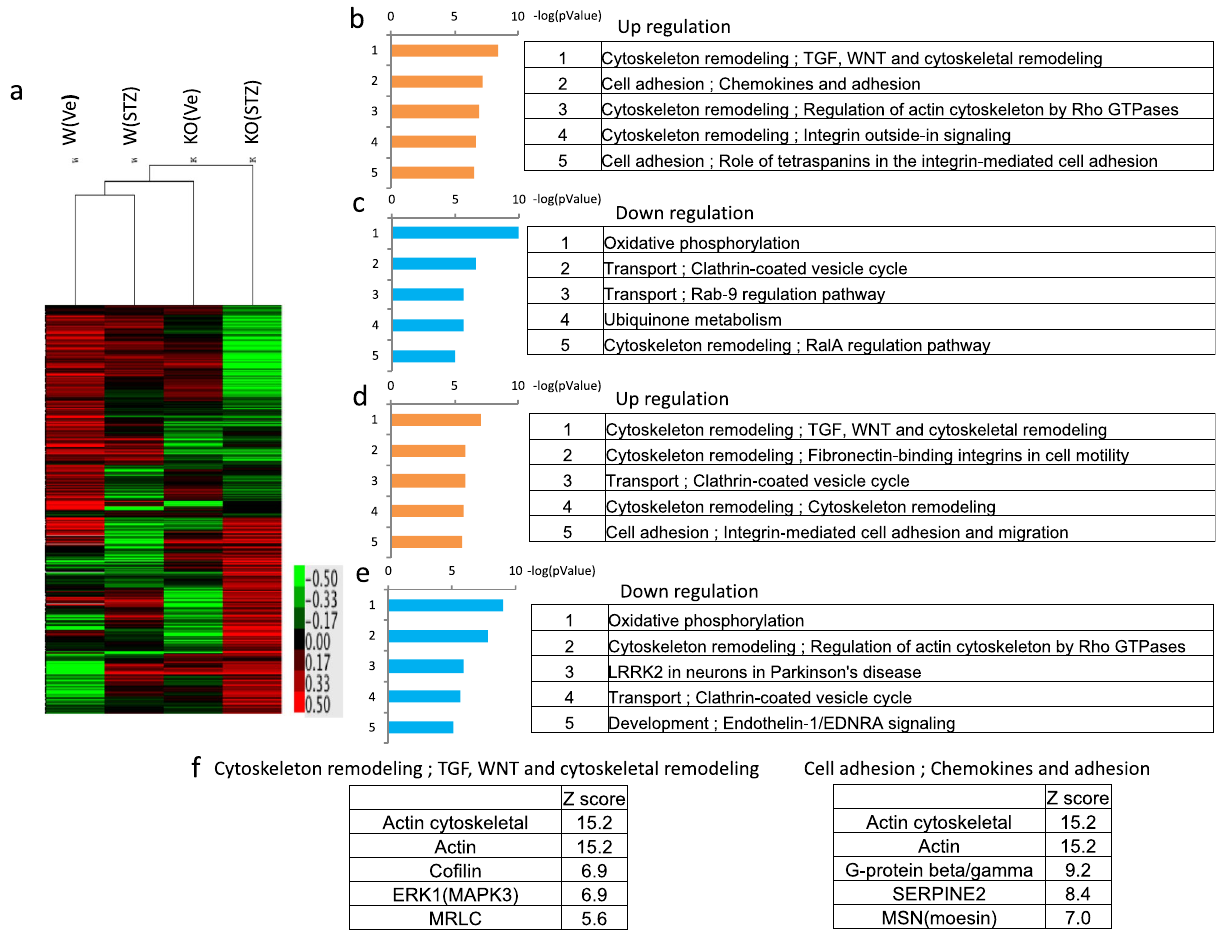
Figure 3. Comprehensive gene analysis in the kidney, and cluster and pathway analysis. As a result of the cluster analysis, gene expression of the 4 groups (WT-Ve, KO-Ve, WT-STZ, KO-STZ) was seen to be significantly different ( a ). Upregulated ( b ) and downregulated ( c ) pathways were listed to compare the WT-STZ and KO-STZ groups. Upregulated ( d ) and downregulated ( e ) pathways were listed to compare the WT-Ve and WT-STZ groups. Lists of high Z-scored molecules included in the cytoskeleton- and cell adhesion-related pathways were shown ( f ). KO, octn1 KO mice; WT, wild type mice; STZ, STZ injected mice; Ve, vehicle